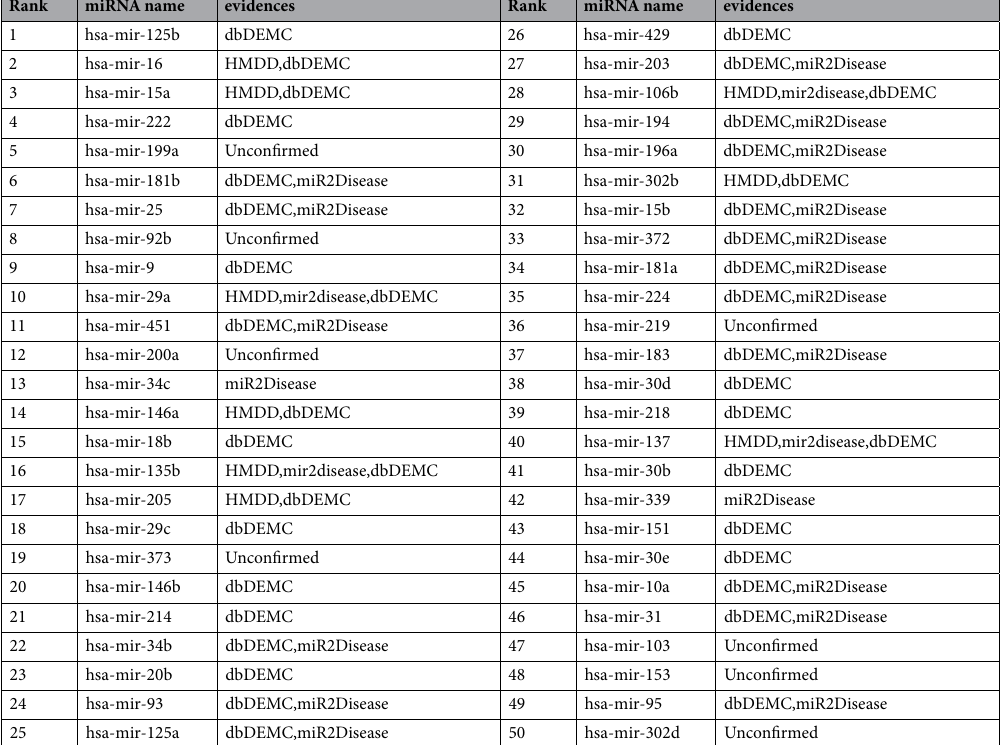
Table 2. The top 50 colon cancer-related miRNAs candidates predicted by GSTRW and the confirmation of these associations. Forty- two of the top 50 potential conlon cancer miRNAs candidates have been confirmed based on the update HMDD, dbDEMC and